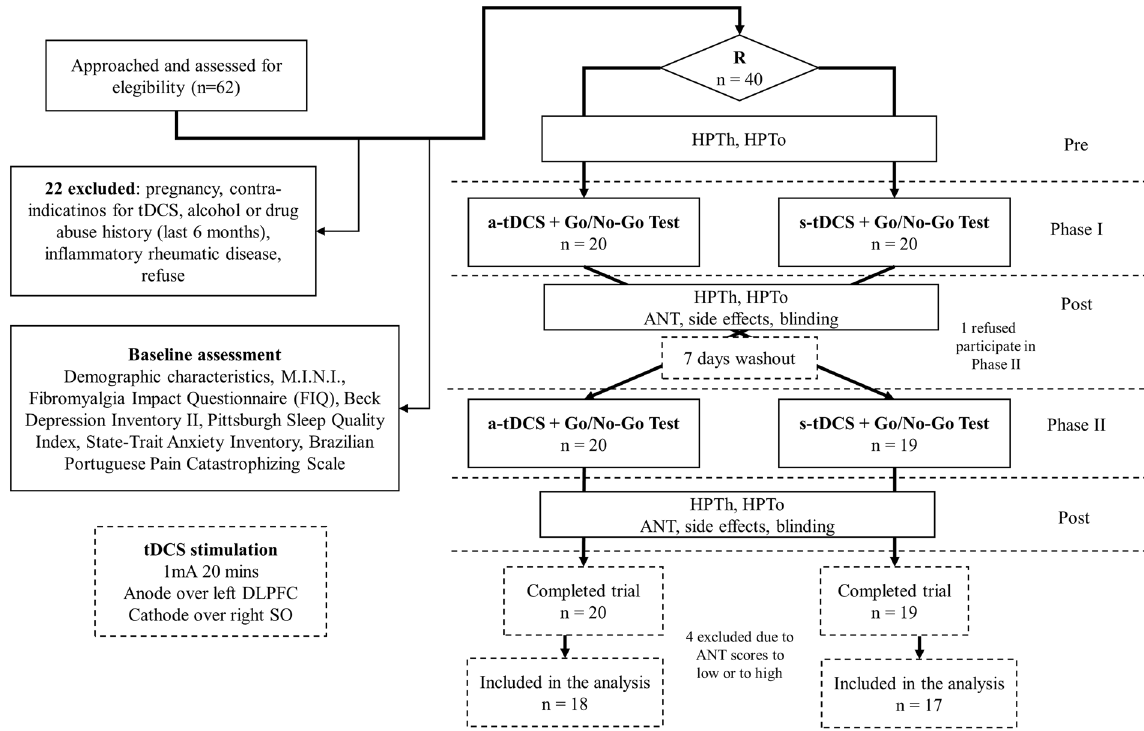
Figure 3. Flowchart showing recruitment and progress through the